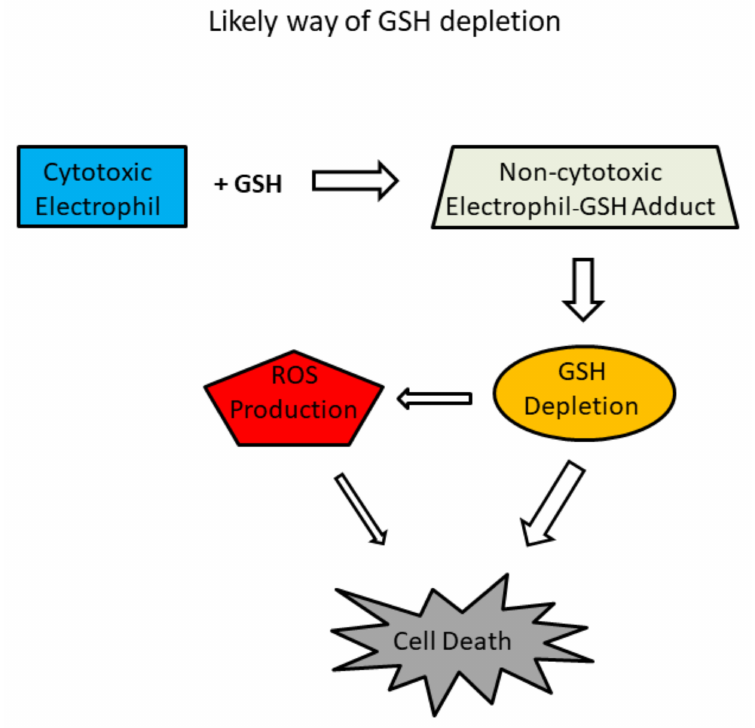
Figure 3. Schematic for predicted GSH depletion. Electrophiles can either directly interact with GSH to form a non-cytotoxic electrophile–GSH adduct or GST (EC 2.5.1.18) can catalyse the conjugation